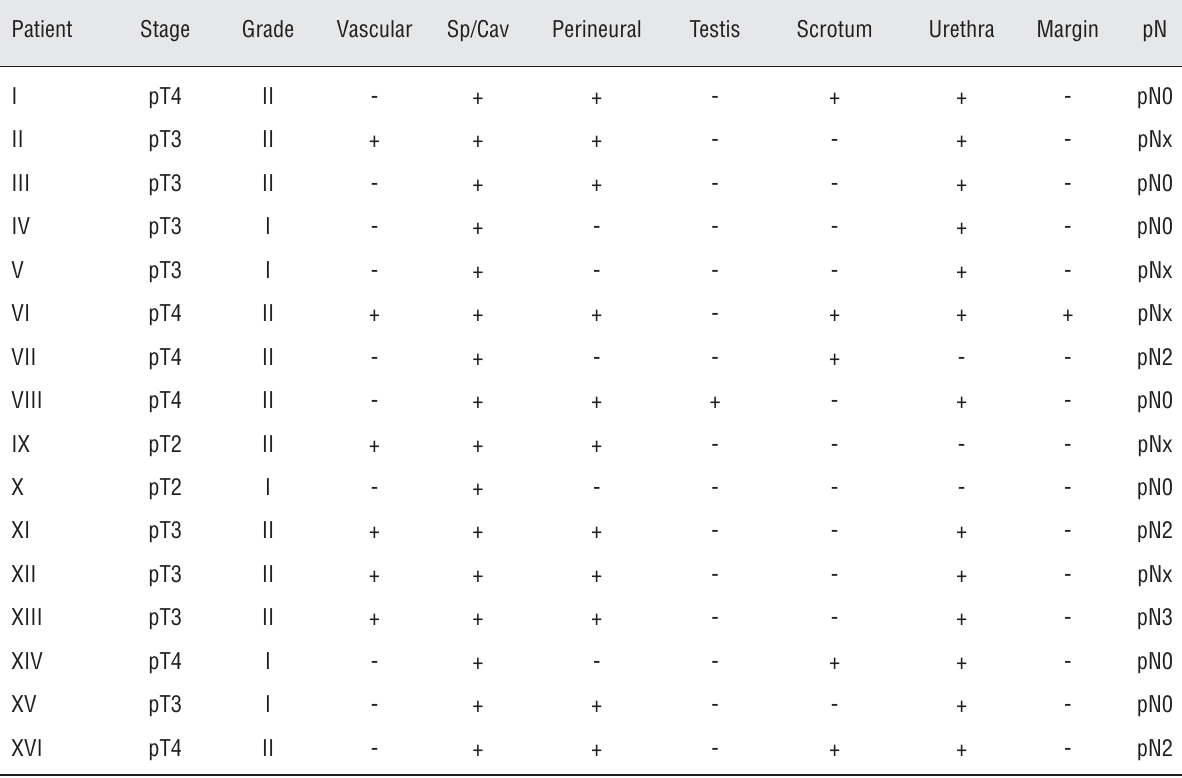
Table 3 - Pathological fi ndings of 16 patients with penile squamous cell carcinoma submitted to emasculation at the Ceará Cancer Hospital in Fortaleza, Brazil, between 1999 and